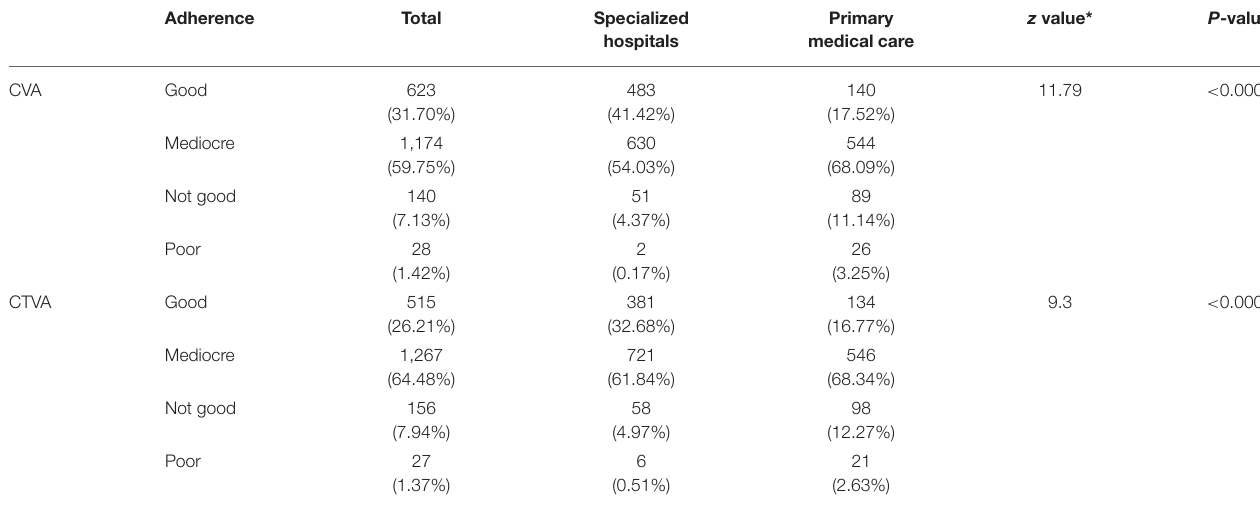
TABLE 4 | Adherences in patients with CVA and CTVA. Adherence